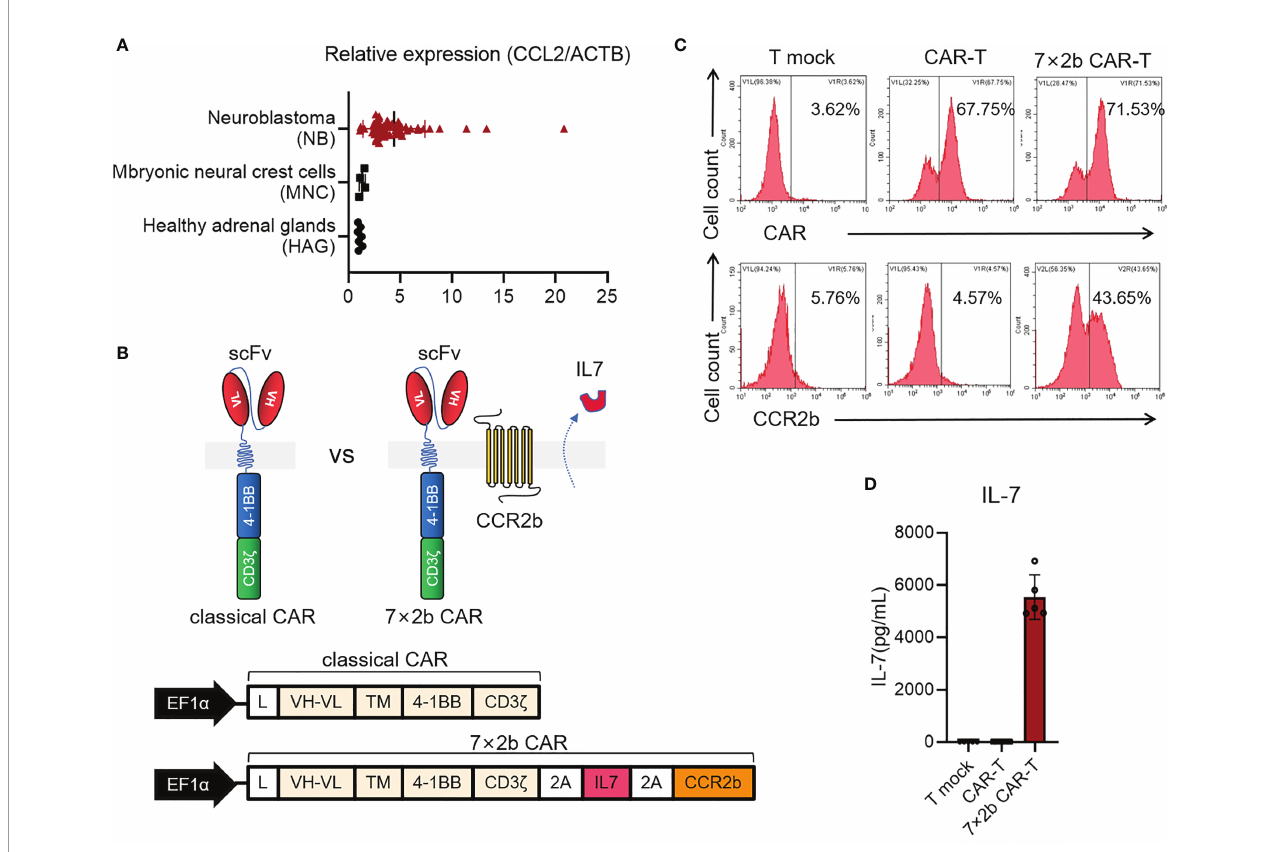
FIGURE 1 | IL-7 and CCR2 co-expression in anti-GD2 CAR-T cells. (A) The mRNA expression of CCL2 was analyzed in GSE96631 from the GEO database. (B) Structure diagram of 7×2b CAR. (C) The expression of CAR and CCR2b in CAR-T cells. (D) The T-mock and CAR-T cells were cultured in a H3 medium without IL-7. IL-7 levels in the supernatant on day 5 were detected by